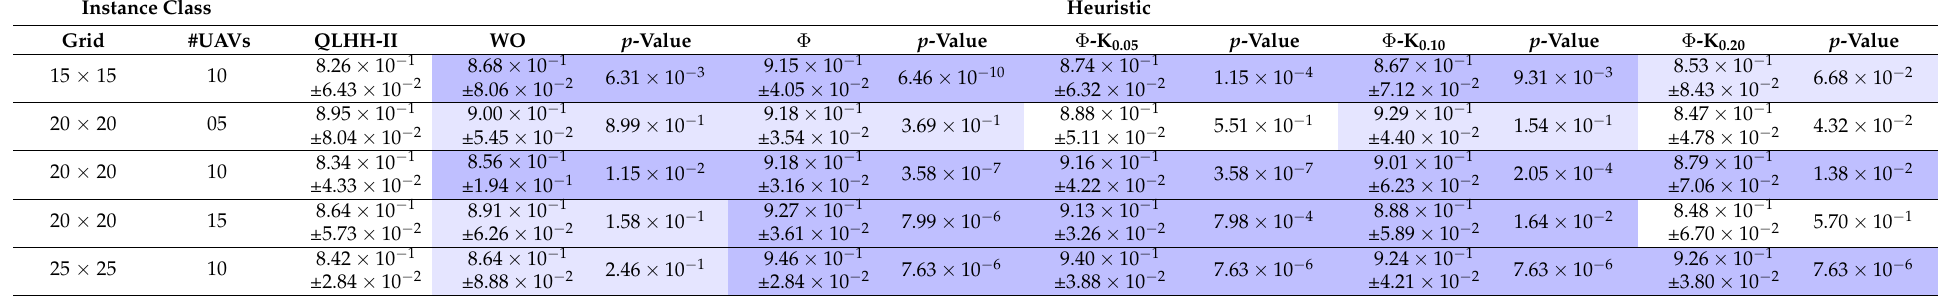
Table 5. Comparison between heuristics according to Δ